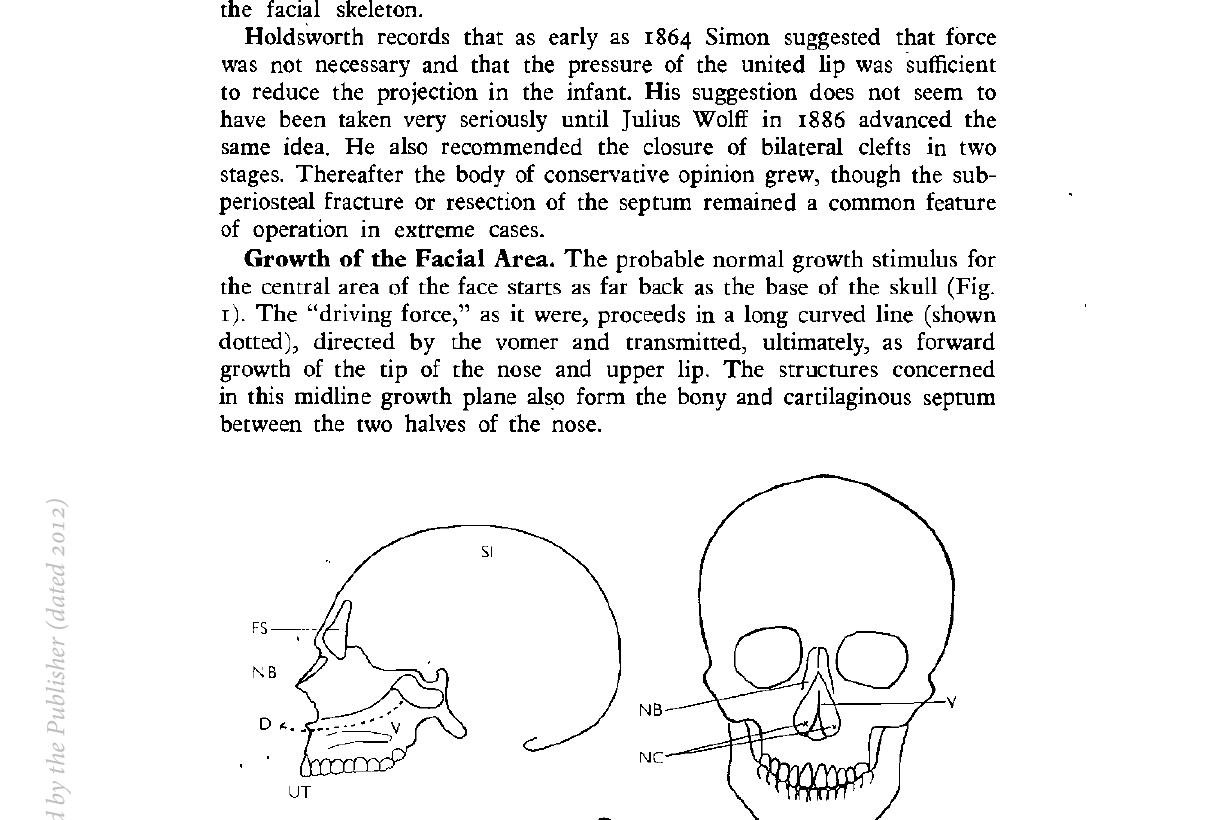
Fig. i. Sagittal section of the skull. SI: Skull interior. FS: Frontal sinus. NB: Nasal bone. UT: Upper teeth. D: Direction of growth of mid-third of face and tip of nose. V: Vomer and nasal septum. Fig. 2. Anterior aspect of the skull. NB: Nasal bones. NC: Nasal cavity. V: Front view of nasal septum